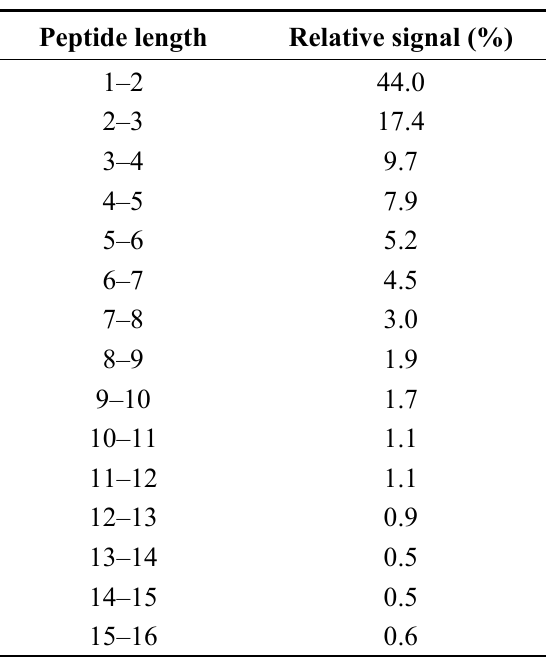
Table 1. Peptide length distribution of the extensively hydrolyzed casein (eCH) as assessed by Edman degradation. Peptide lengths and their relative abundance are presented, showing a mixture of peptides with a large proportion of smaller sequences of less than 1000 Da, typical of an extensive